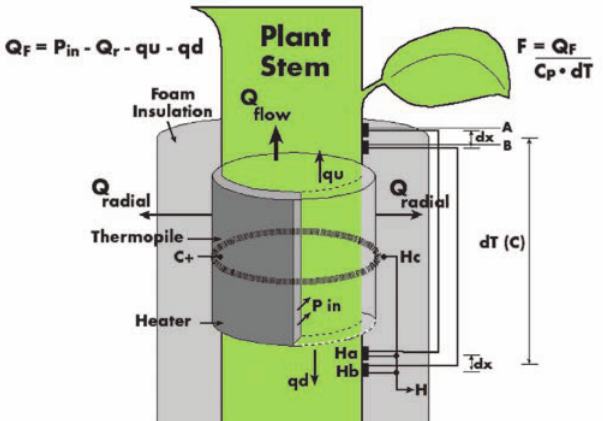
Figure 1. Stem gage schematics (Dynamax